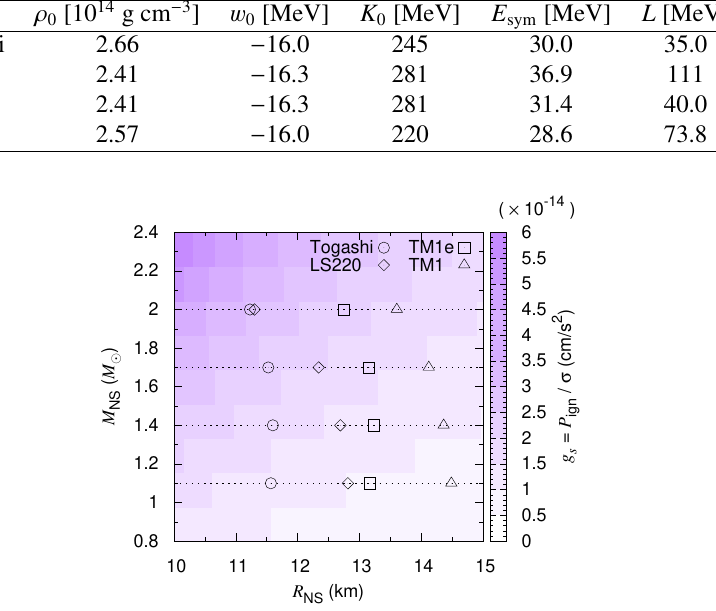
Figure 1. The surface gravity g s on the mass–radius plane based on the shell-flash model. The symbols indicate the values with our adopted